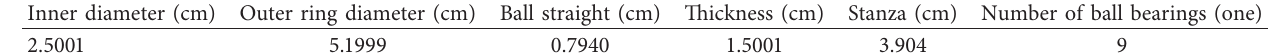
Table 1: Main parameters of bearing.